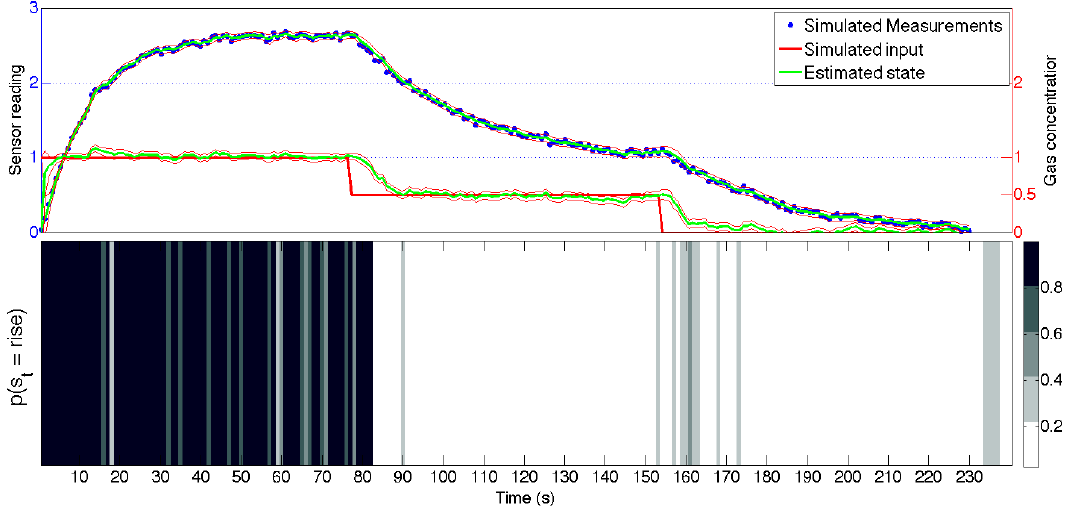
Figure 7. The aSLDS inference results on the artificial dataset. ( Top ) Measurements and estimated input ( Bottom ) Grayscale representation of p ( s white is